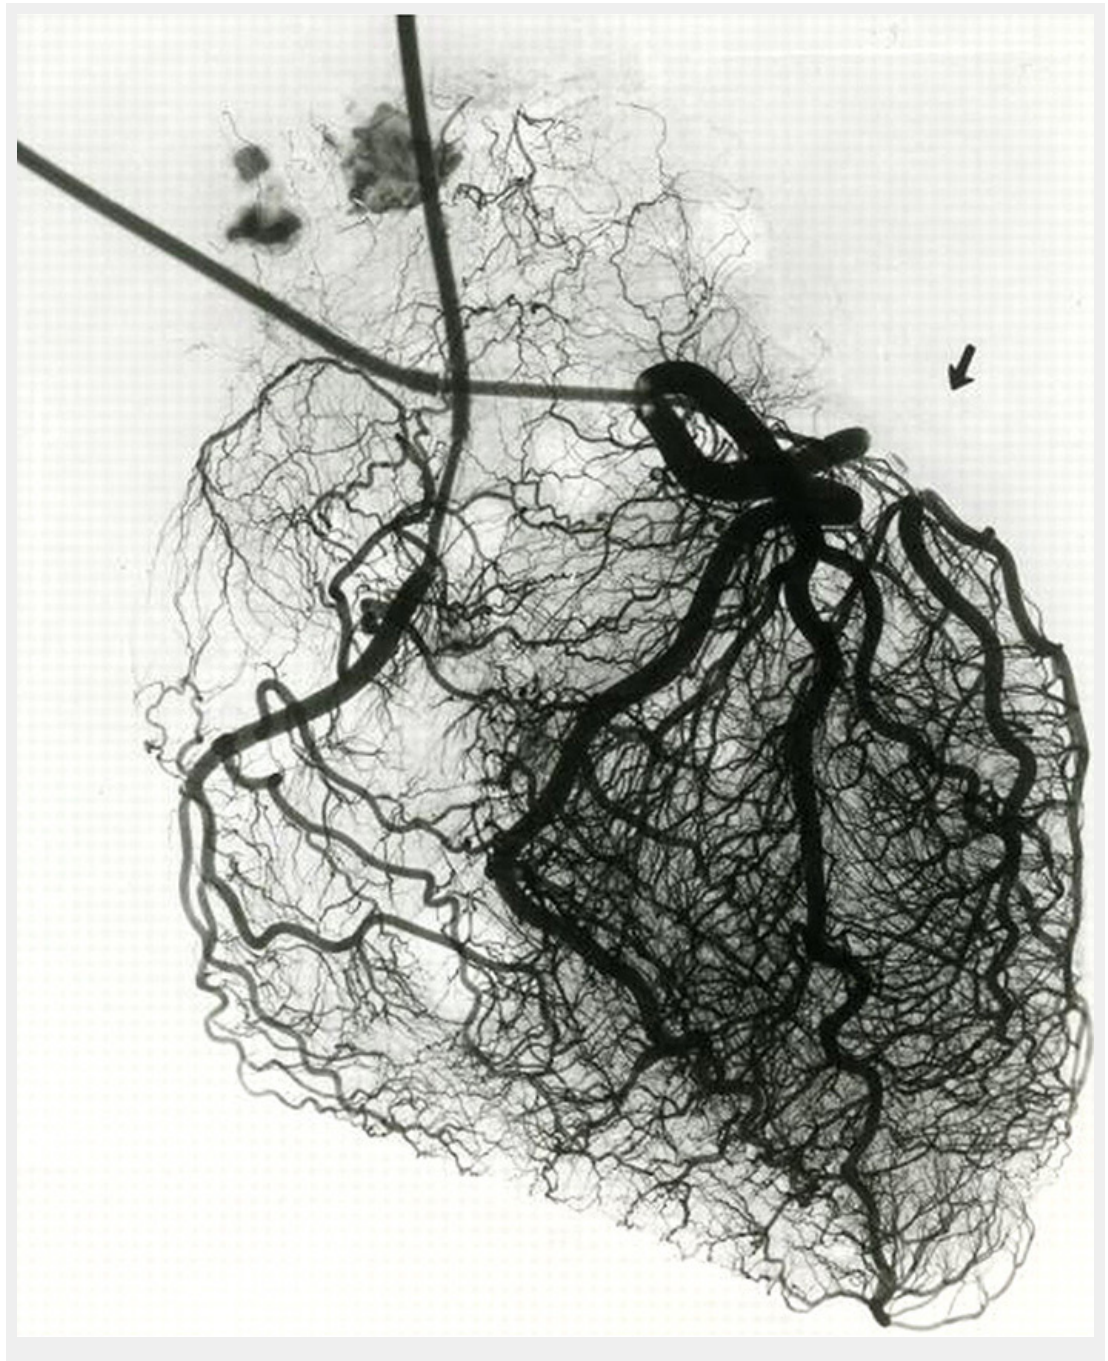
Figure 4 Immersion radiography of an ex vivo arteriogram of a normal human heart. Tissue shadows are almost eliminated by immersion of the specimen in saline. Blood vessels are radiologically demonstrated to 20 µm, a spatial resolution sufficient to reproduce the dense collateral network, over which retrograde filling of the branch of the left circumflex coronary artery doubly ligated (arrow) before contrast injection occurs. In contrast, coronary angiography does not detect the majority of anastomotic vessels due to its inferior spatial resolution. (Data from Fulton WF. Immersion radiography of injected specimens. Br J Radiol. 1963;36:685–8 [121], by permission of the Oxford University